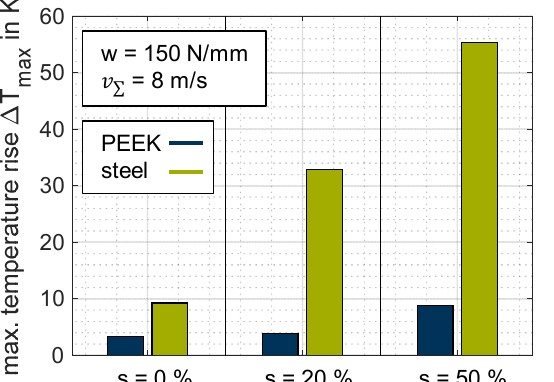
Figure 15. Comparison of the pressure profile for the thermoplastic EHL contact PEEK/ZrO 2 (blue) and steel EHL contact steel/ZrO 2 (green) for line load w = 150 N/mm, v ∑ = 8 m/s and s = 0%.